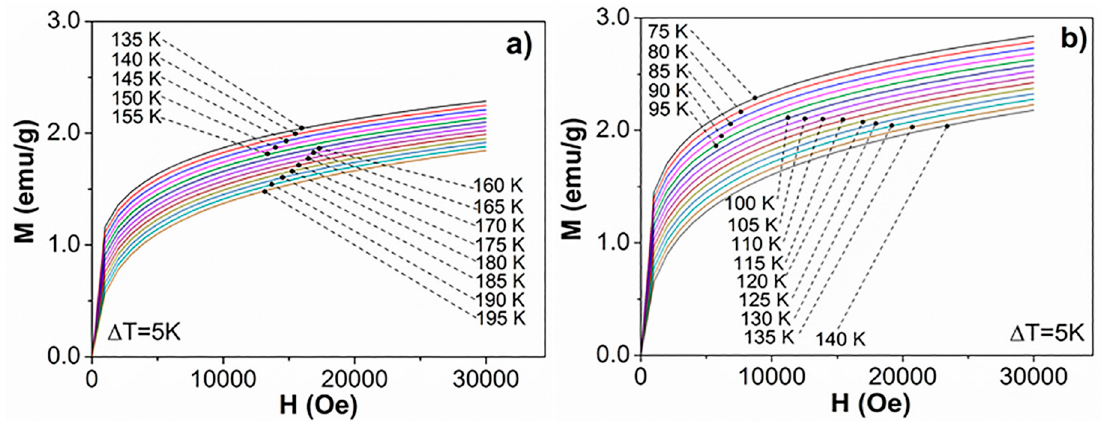
Figure 5. Isothermal magnetization curves of samples subjected to ( a ) quenching and ( b ) normalizing. The magnetic field varied from 0 to 3 Tesla, and ∆ T = 5 K.